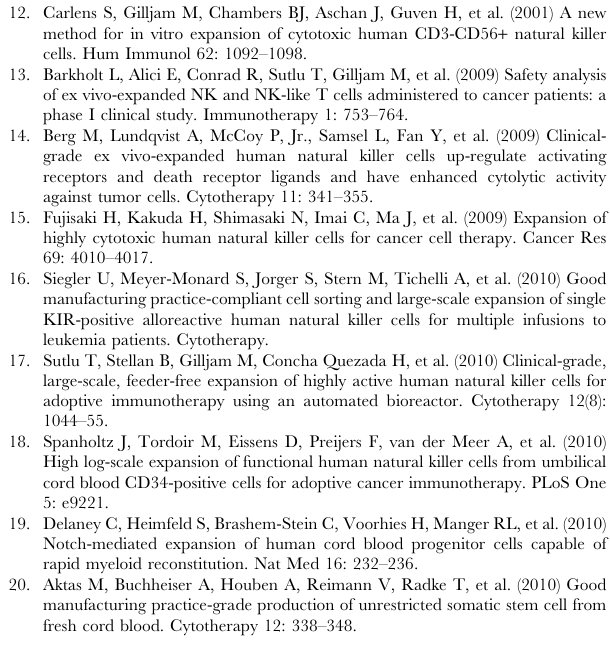
Figure S2 Stability tests of ex-vivo generated and pro- cessed NK cell products. (A–D) The CD45 + CD56 + CD3 2 7AAD 2 lymphocytes from two different donors (A&B and C&D) were analyzed for several NK cell specific surface antigens and followed over time. (A and C) The products were either stored at 4 u C or (B and D) at room temperature (RT) for a maximum of 3